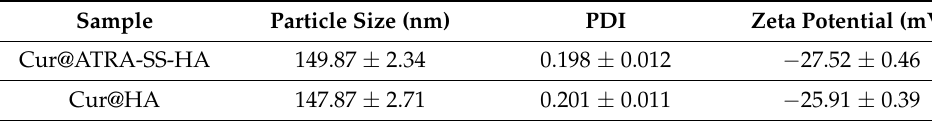
Table 1. Particle size, PDI and Zeta potential of Cur@ATRA-SS-HA and Cur@ HA.